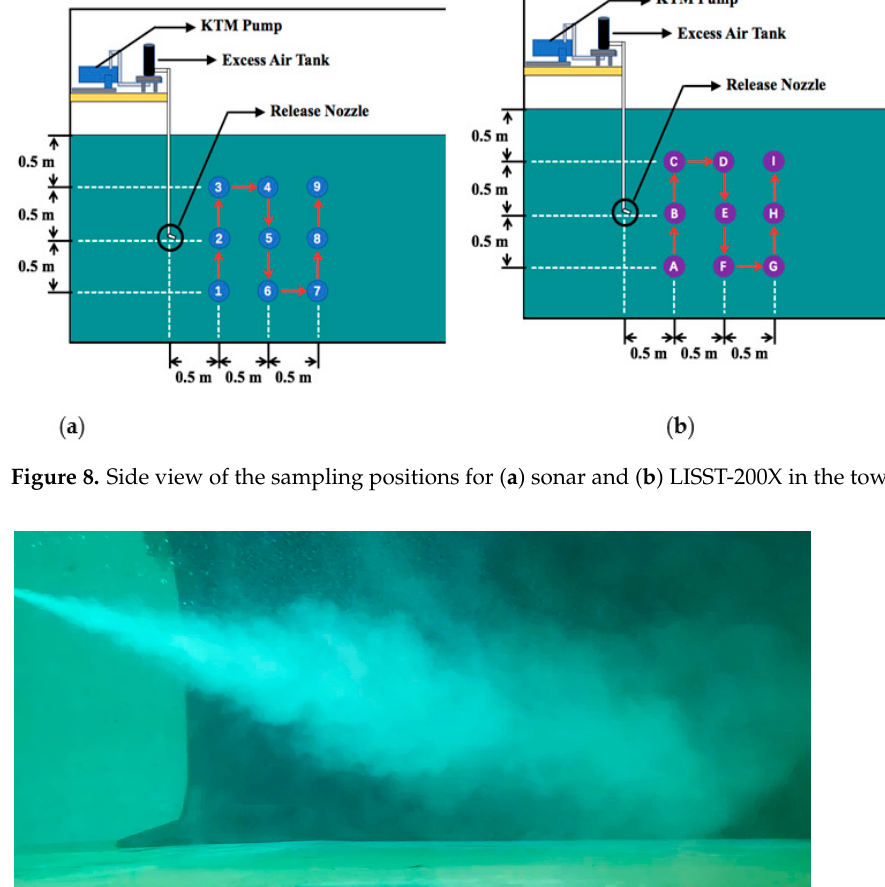
I Figure 7. Sampling positions for the sonar and LISST-200X in the tow tank.